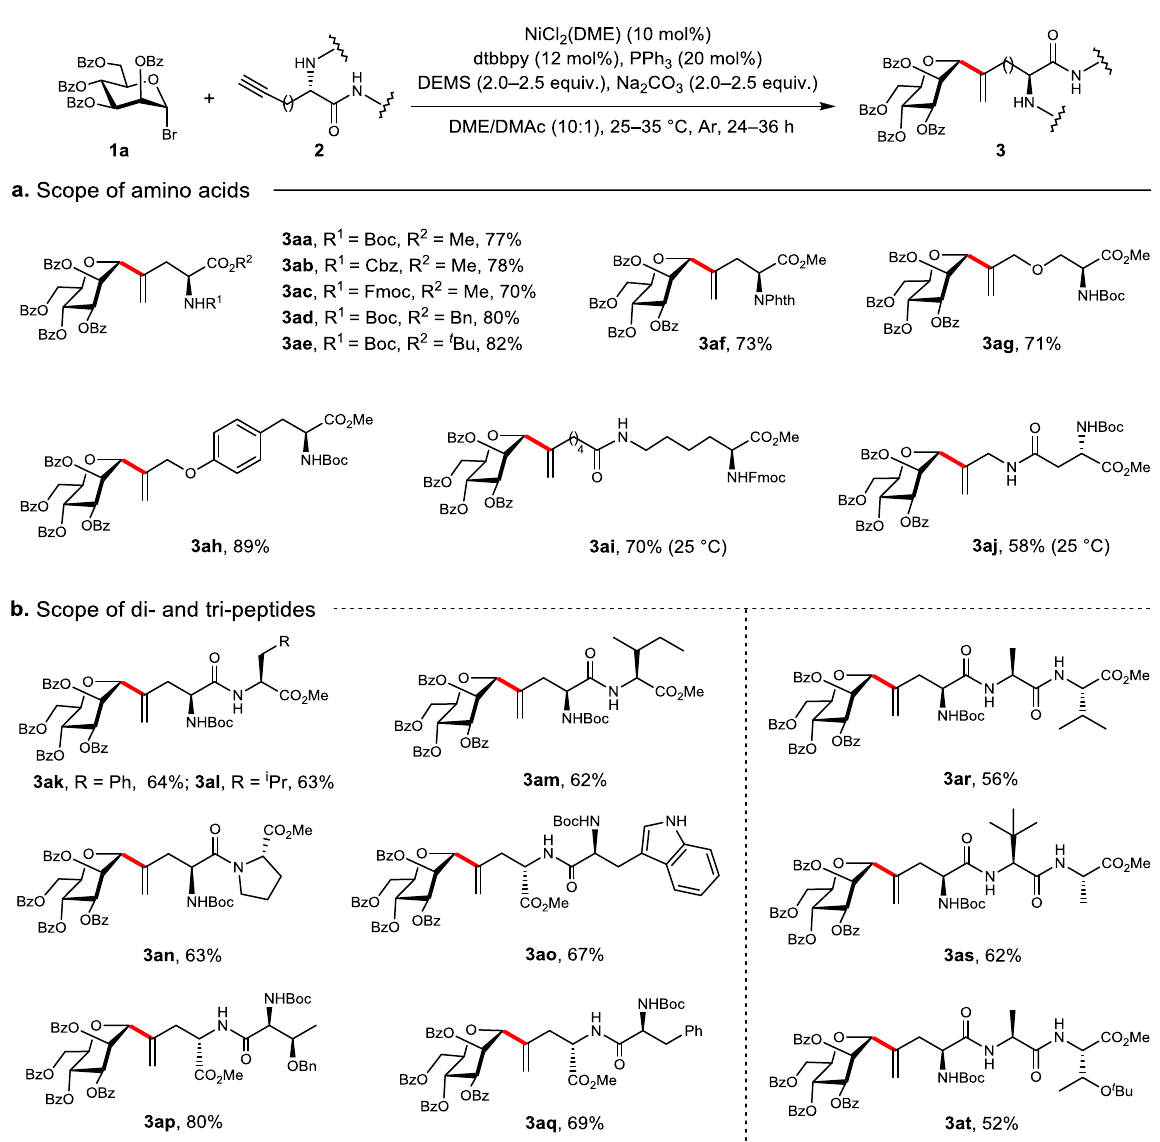
Fig. 3 C -Mannosylation of alkyne derivatives of amino acids and peptides. 1a (0.1 mmol), 2 (2.0 equiv.), NiCl 2 (DME) (10 mol%), dtbbpy (12 mol%), PPh 3 (20 mol%), DEMS (2.5 equiv.), Na 2 CO 3 (2.5 equiv.), DME/DMAc (10/1, v/v, 1 mL), 25 – 35 °C, Ar, 36 h. Isolated yields are reported. In red are the formed C -glycosidic